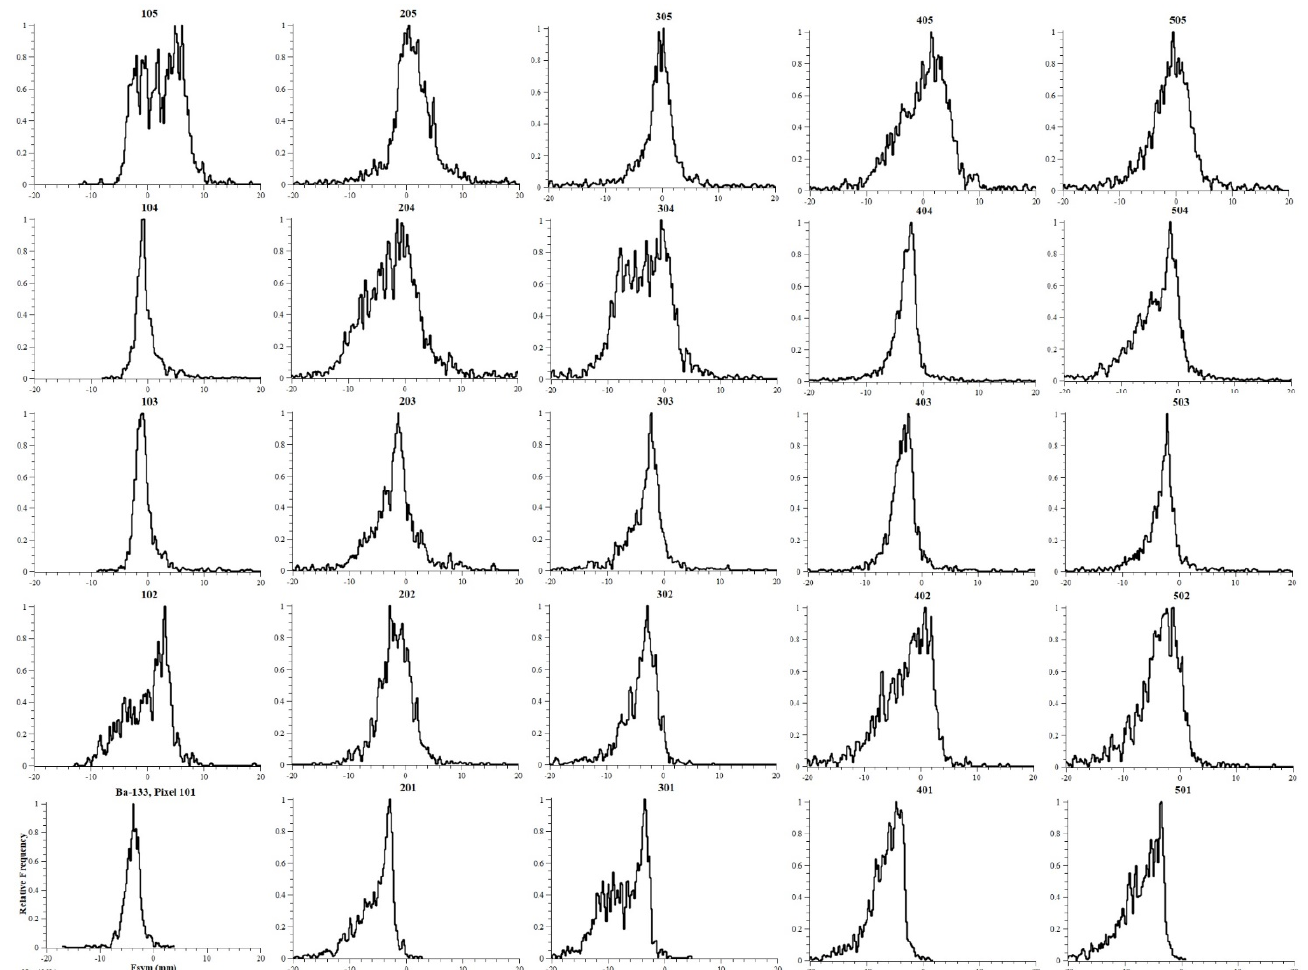
Figure A9. Fsym spectra per pixel for the first quarter of crystal-array under Ba-133 point-source irradiation. The first quarter includes the pixels with RR ≤ 5 and CC ≤ 5. The common axes and the plot descriptions are reported only once in the bottom-left frame. The spectra, obtained by building histograms from single-events Fsym values with 0.2 mm binning, have undergone smoothing for denoising data. The frequency values were normalized, pixel by pixel, to the respective maximum value.